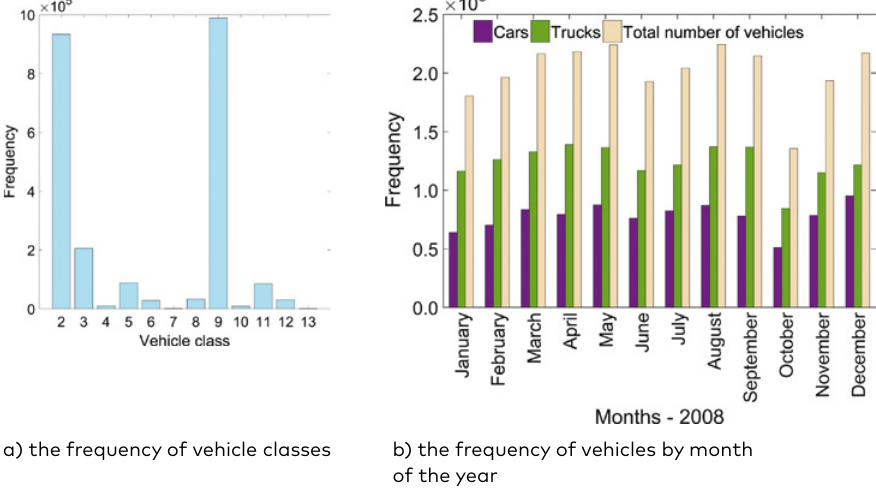
Figure 1. Measured Weigh-in-Motion data after